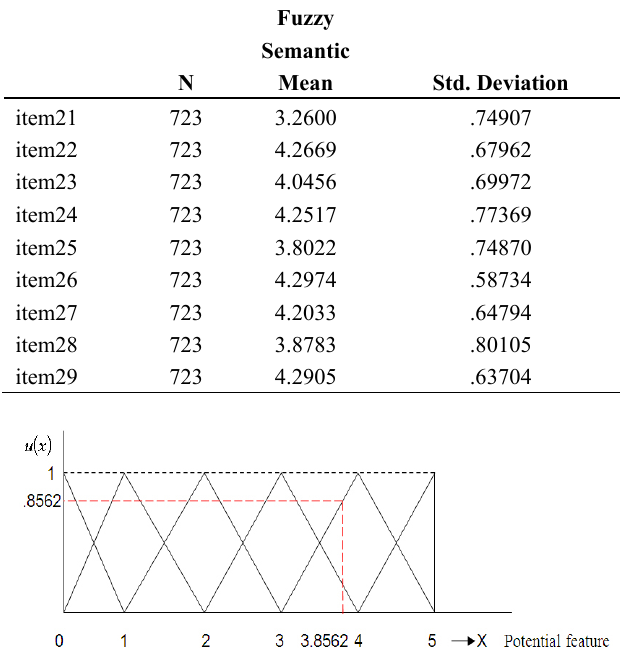
Figure 6: The membership function figure of five-level semantic variables